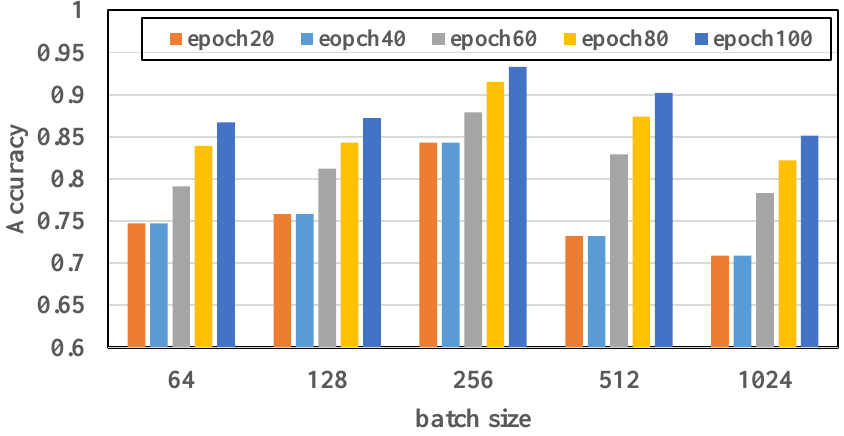
Figure 15. Different batch sizes.